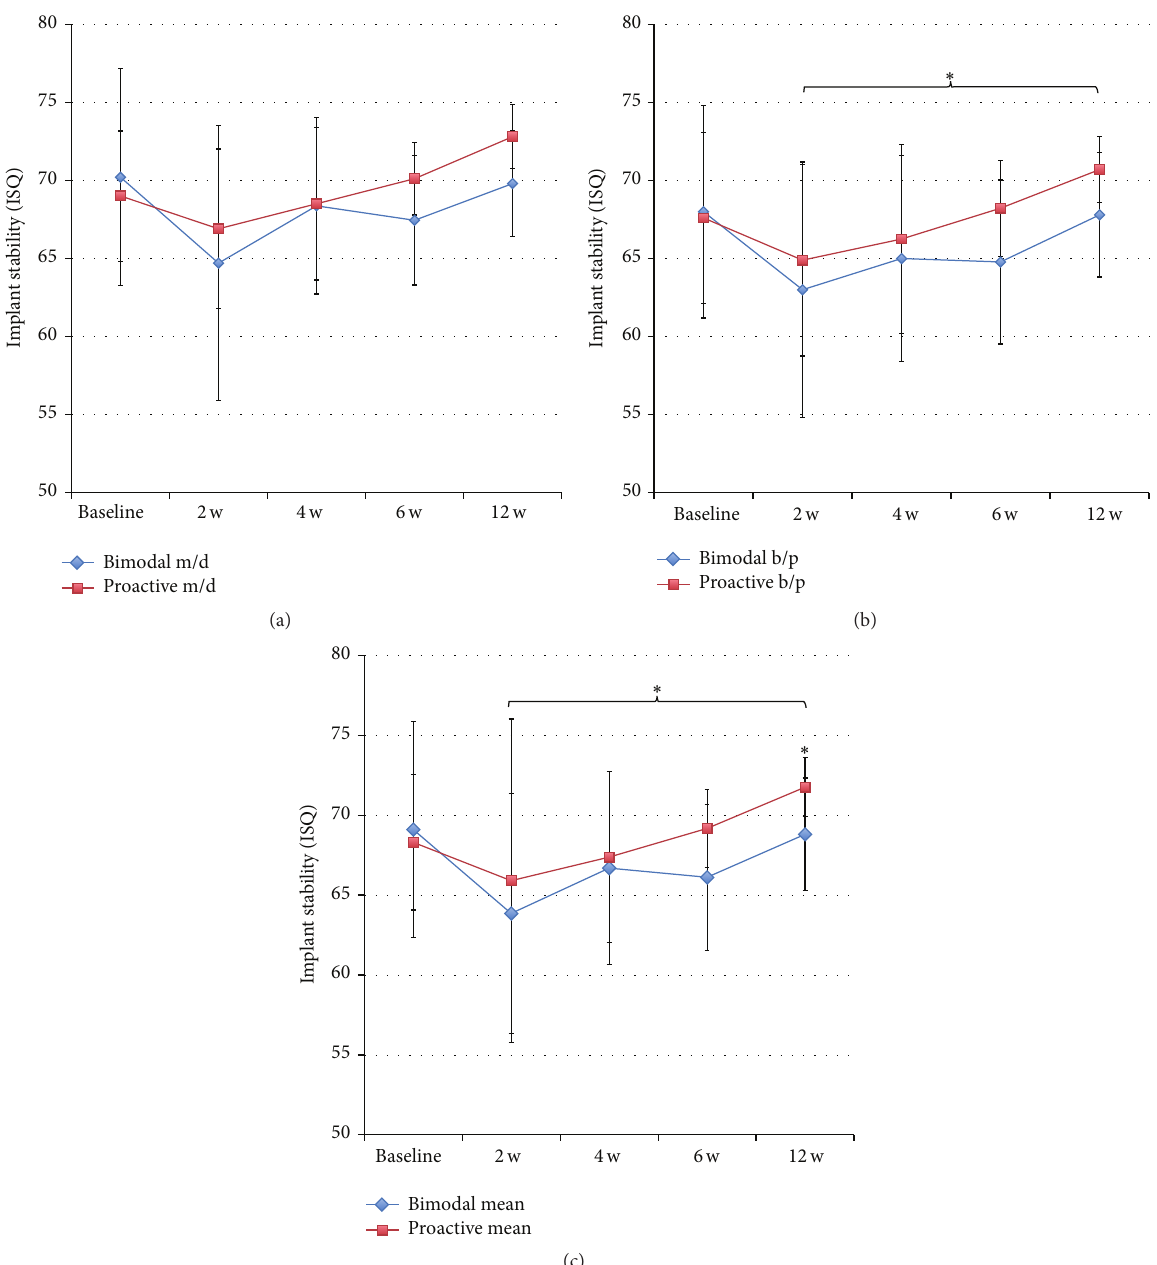
Figure 3: (a) Showing the results from RFA measurements of bimodal and proactive implants in MD direction. (b) Showing the results from RFA measurements in BP direction. ∗ 𝑝 ≤ 0.05 . (c) Showing results from RFA measurements as mean values. ∗ 𝑝 ≤ 0.05